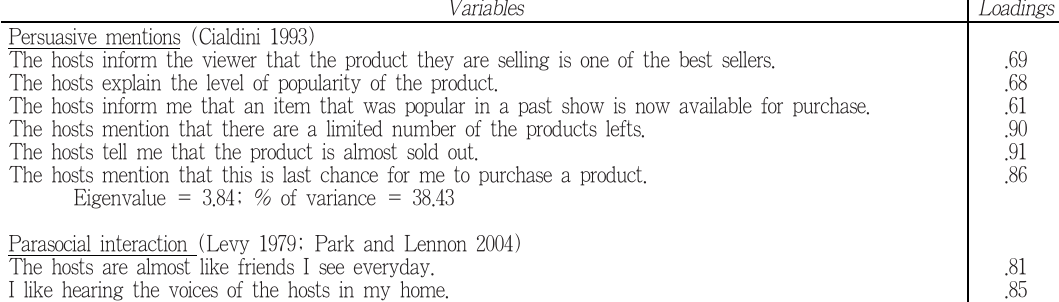
<Table 1> Exploratory factor analysis for construct validity